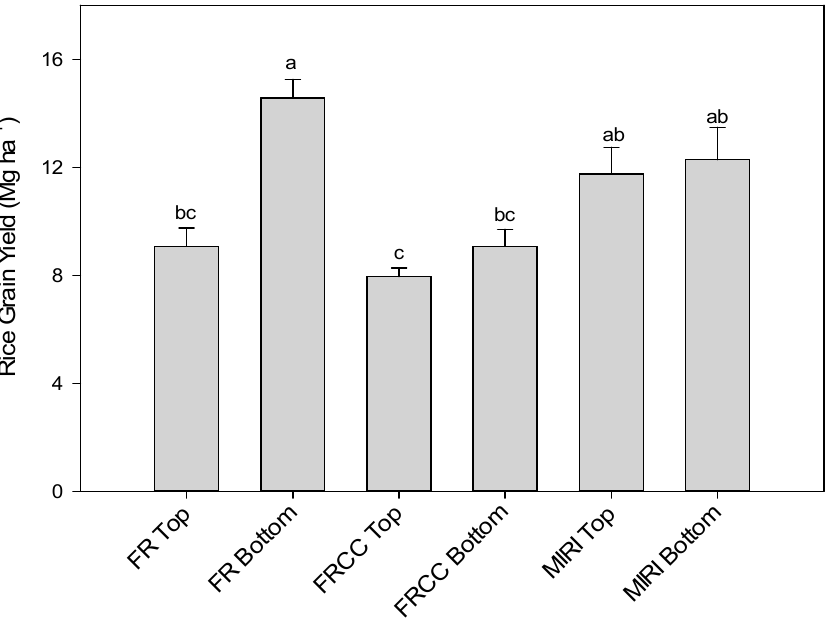
Figure 4. Rice grain yields at the top and bottom sections of a furrow-irrigated rice field (FR), a furrow-irrigated rice with winter cover crop field (FRCC) and a multiple-inlet rice irrigation field (MIRI) during the 2019 growing season. Data shown are average ± standard error ( n = 3). Different letters denote a statistical difference ( p < 0.05) among treatments.